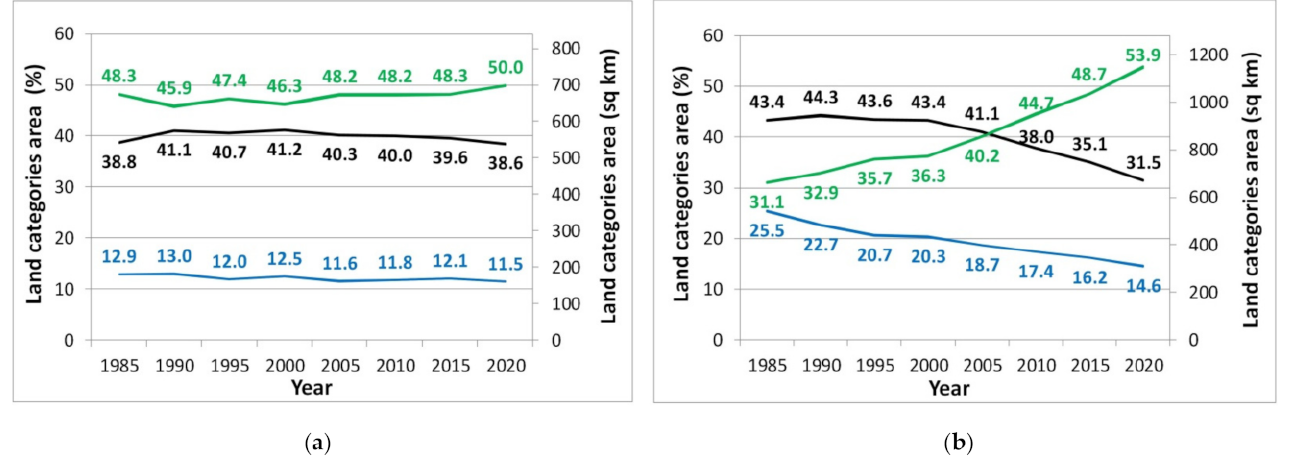
Figure 11. The dynamic of the afforestation within the administrative districts: ( a ) Liozno district (Belarus); ( b ) Rudnya district (Russia). Legend: Arable lands (black), forest (green), other lands